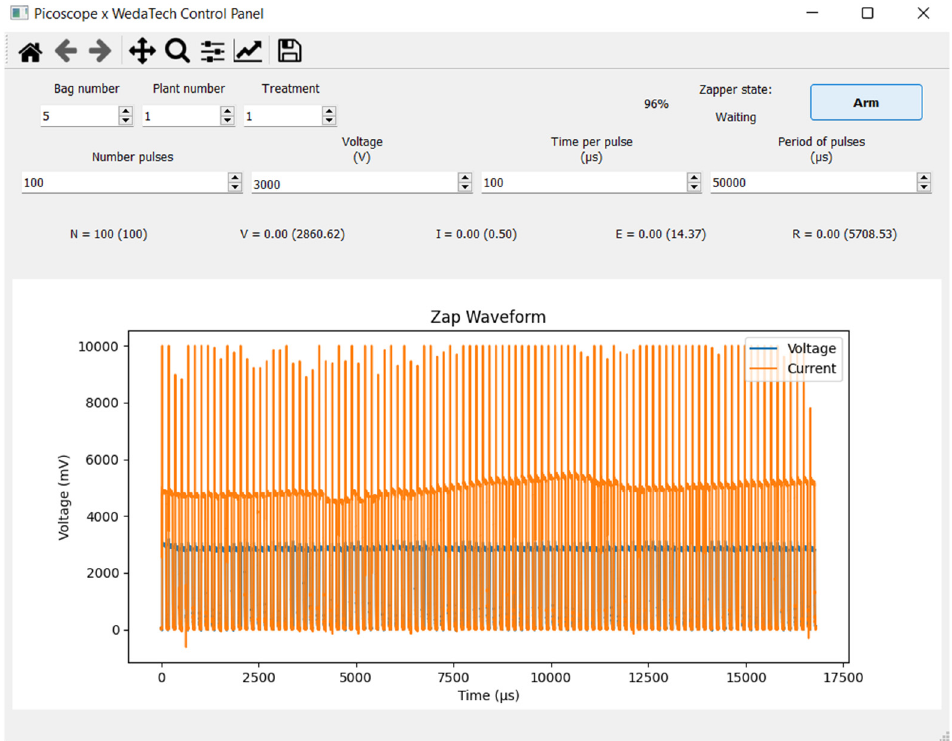
Figure 2. Example of Weda Tech Zapper control screen shows controllable micro-shock parameters, oscilloscope trace, and measured and calculated electrical values .